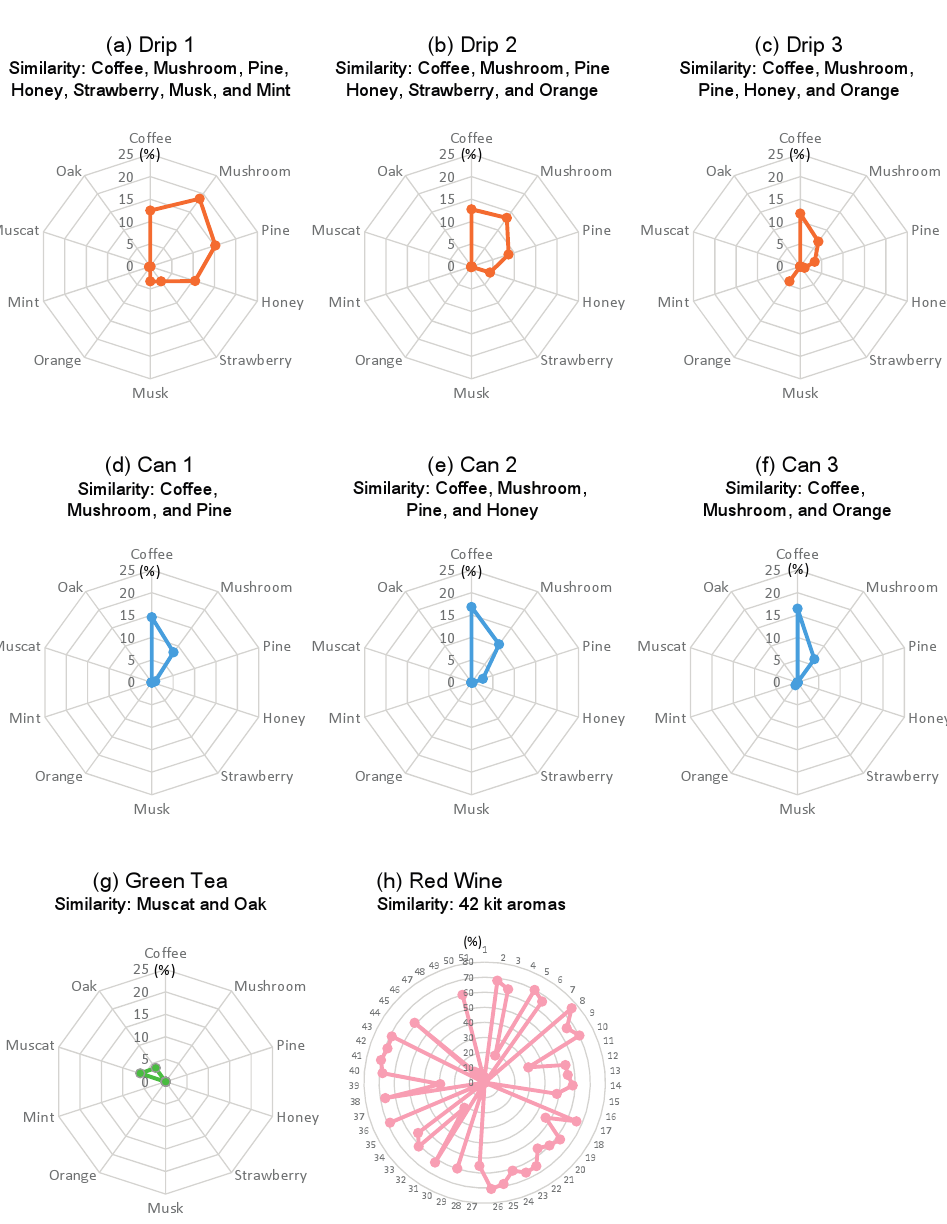
Figure 2. Aromatic similarity patterns of coffees ( a – f ), green tea ( g ), and red wine ( h ) ( n = 3). The similarity levels are expressed in %. The loop numbers in (h) correspond to